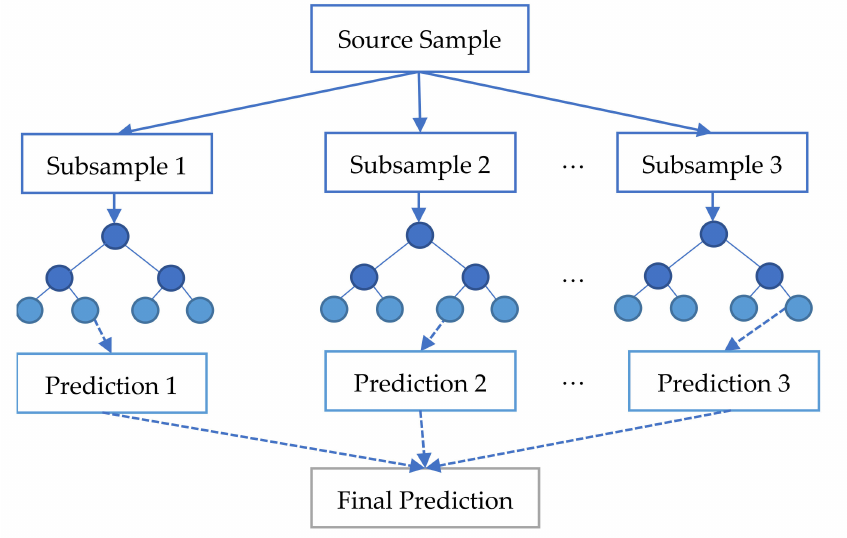
Figure 4. Random forest structure